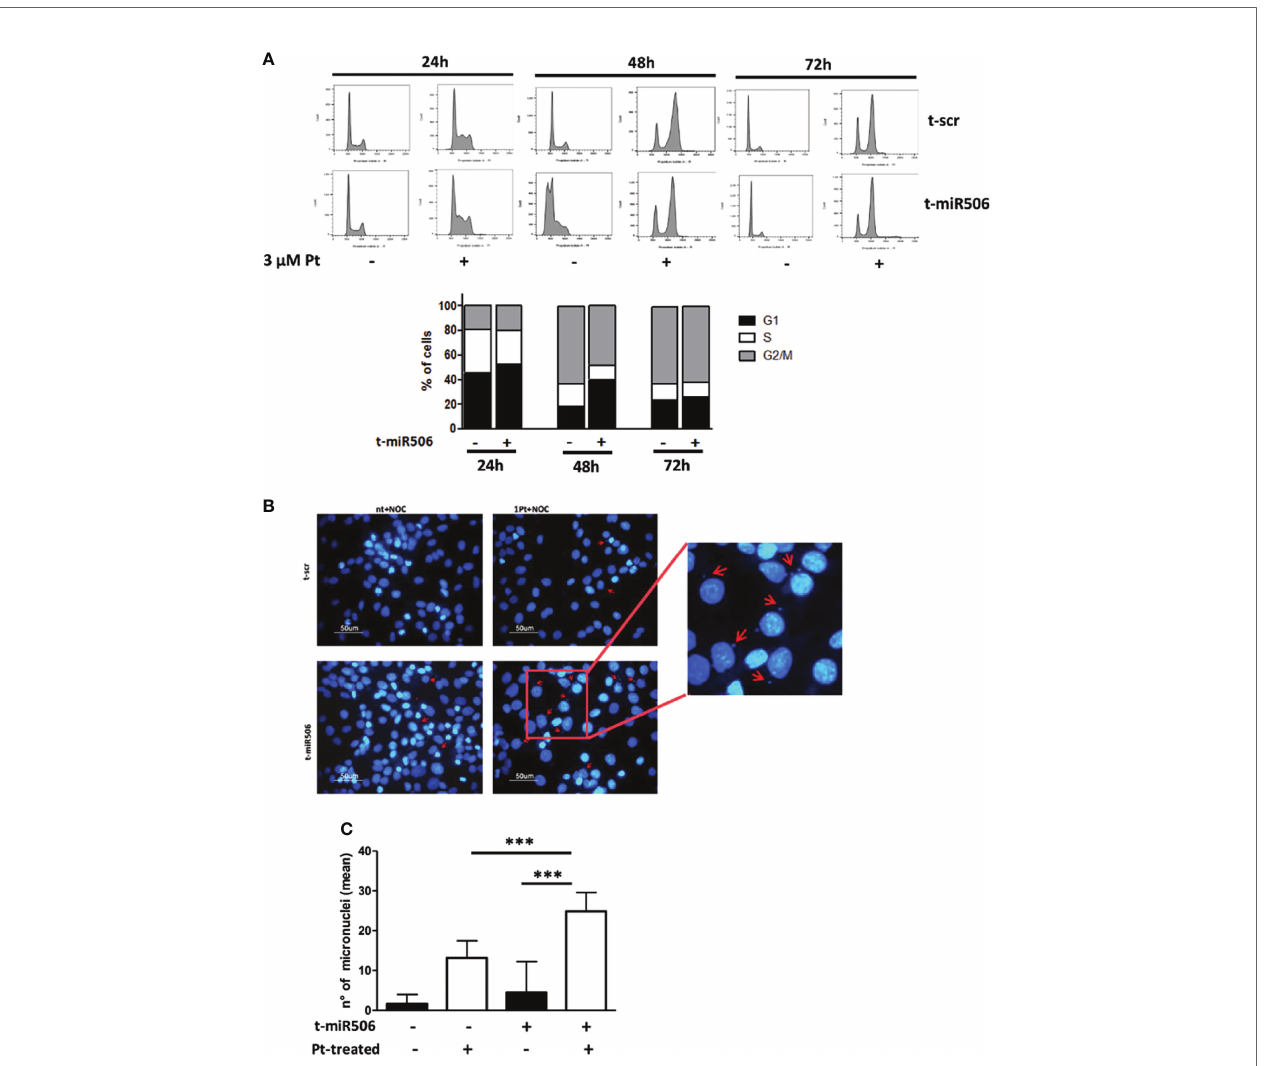
FIGURE 5 | MiR-506-3p causes a delay in Pt-induced G2 cell cycle arrest and increases micronuclei formation. (A) Flow cytometry analysis of the cell cycle distribution (Propidium Iodide staining) in SKOV3 cells transfected with scrambled (scr) control miR or miR-506-3p mimic. Cells were left untreated or treated with 3 m M Pt and cell cycle was analyzed at three time points (24, 48 72 hours). Upper Panel: Representative experiment; Lower Pan el: Percentage of Pt-treated cells in different cell cycle phases at the indicated time points as assessed by ModFit Analysis Software. Mean of three independent experiments is reported. Representative images (B) and quanti fi cation (C) of micronuclei structures in SKOV3 cancer cells labeled with DAPI. SKOV3 cells were transfected with miR-506-3p mimic or scrambled (scr) control miR and treated for 48h with 3µM Pt and nocodazole (150ng/ml). Micronuclei are indicated by red arrows. Data represent the mean ± SD of six different fi elds corresponding to two independent experiments (Student ’ s t test; ***